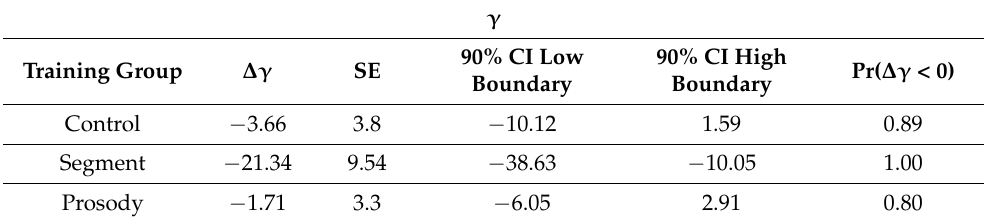
Table 11. Statistical results for voicing during